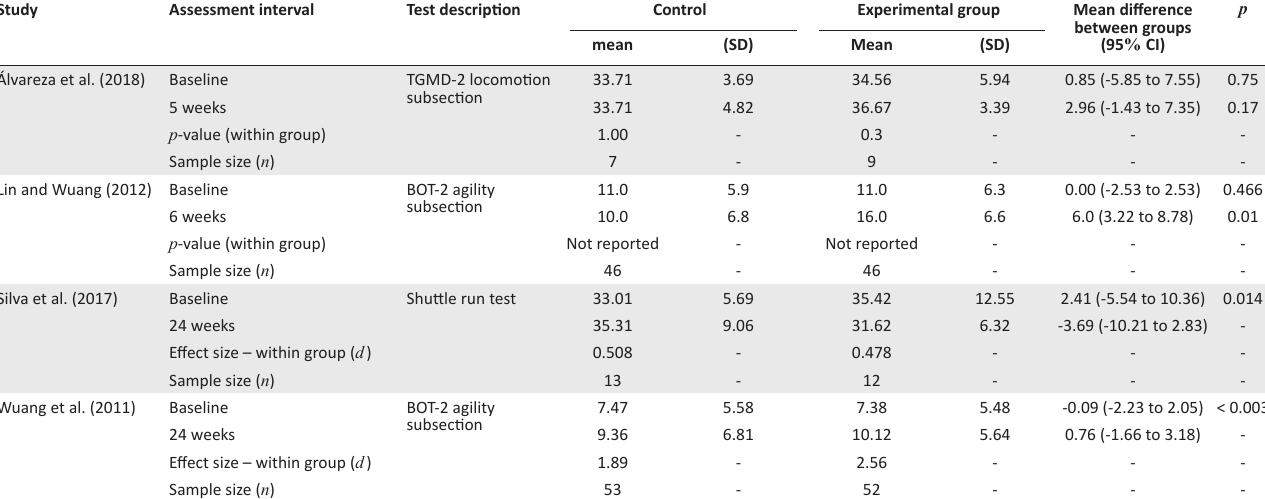
TABLE 5 : Results reported for agility measures of included studies. Study Assessment interval